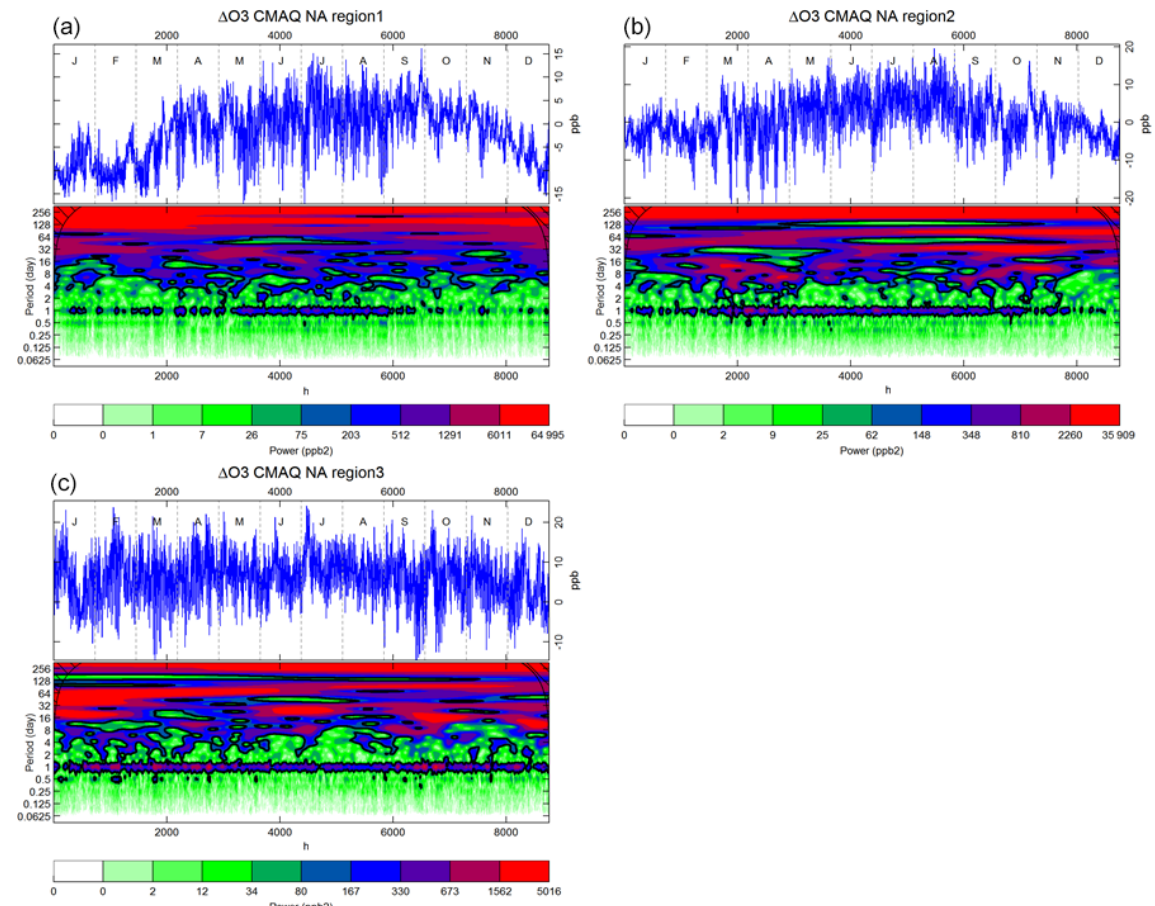
Figure 18. Annual time series of differences between CMAQ and observed O 3 ( (cid:49) O 3 , top portion of each panel) and Morlet wavelet analysis of the periodogram of (cid:49) O 3 (lower portion of each panel) for the three NA subregions. Black contours lines identify the 95% confidence interval. The period (in days) is reported in the vertical axis, while the quantiles of the power spectral density are measured in ppb 2 . (The scale reports the quantiles of the power